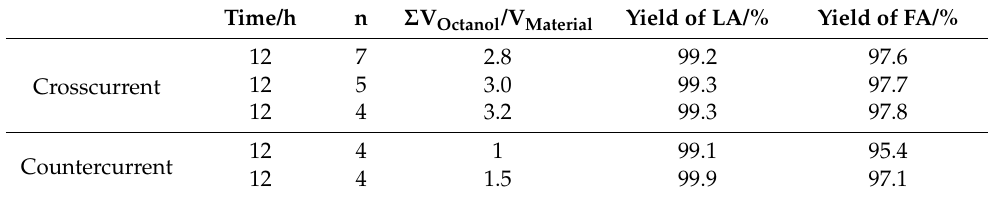
Table 6. Summary of conditions for levulinic acid yield reached